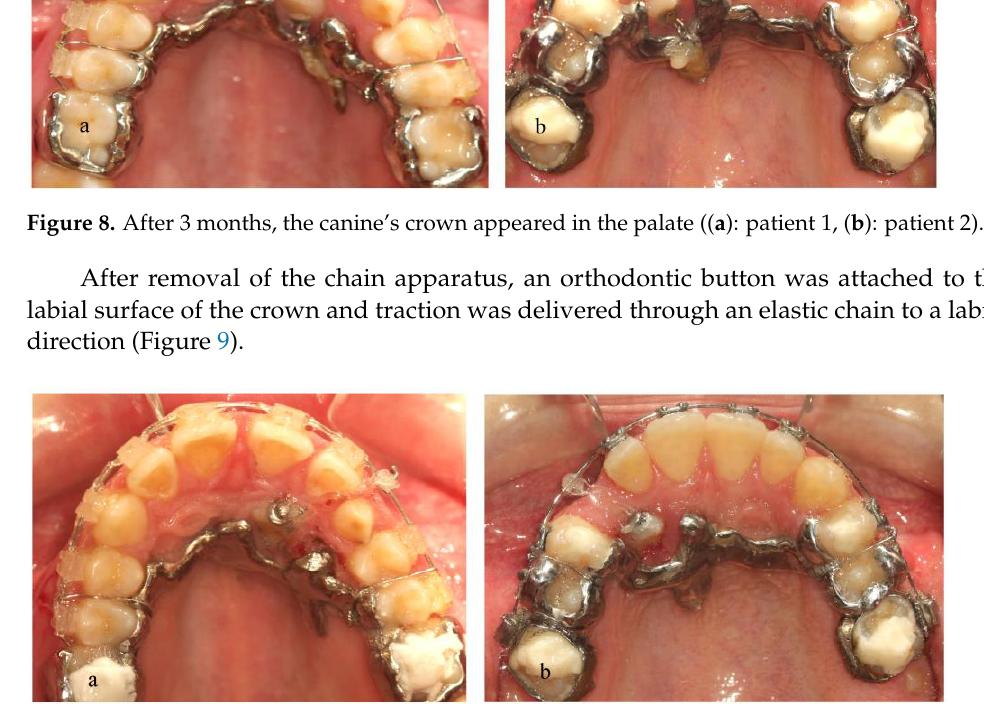
Figure 9. Traction of the canine to a labial direction (( a ): patient 1, ( b ): patient 2). At that point, the metal device was removed from the patients’ mouth ( Figure 10).